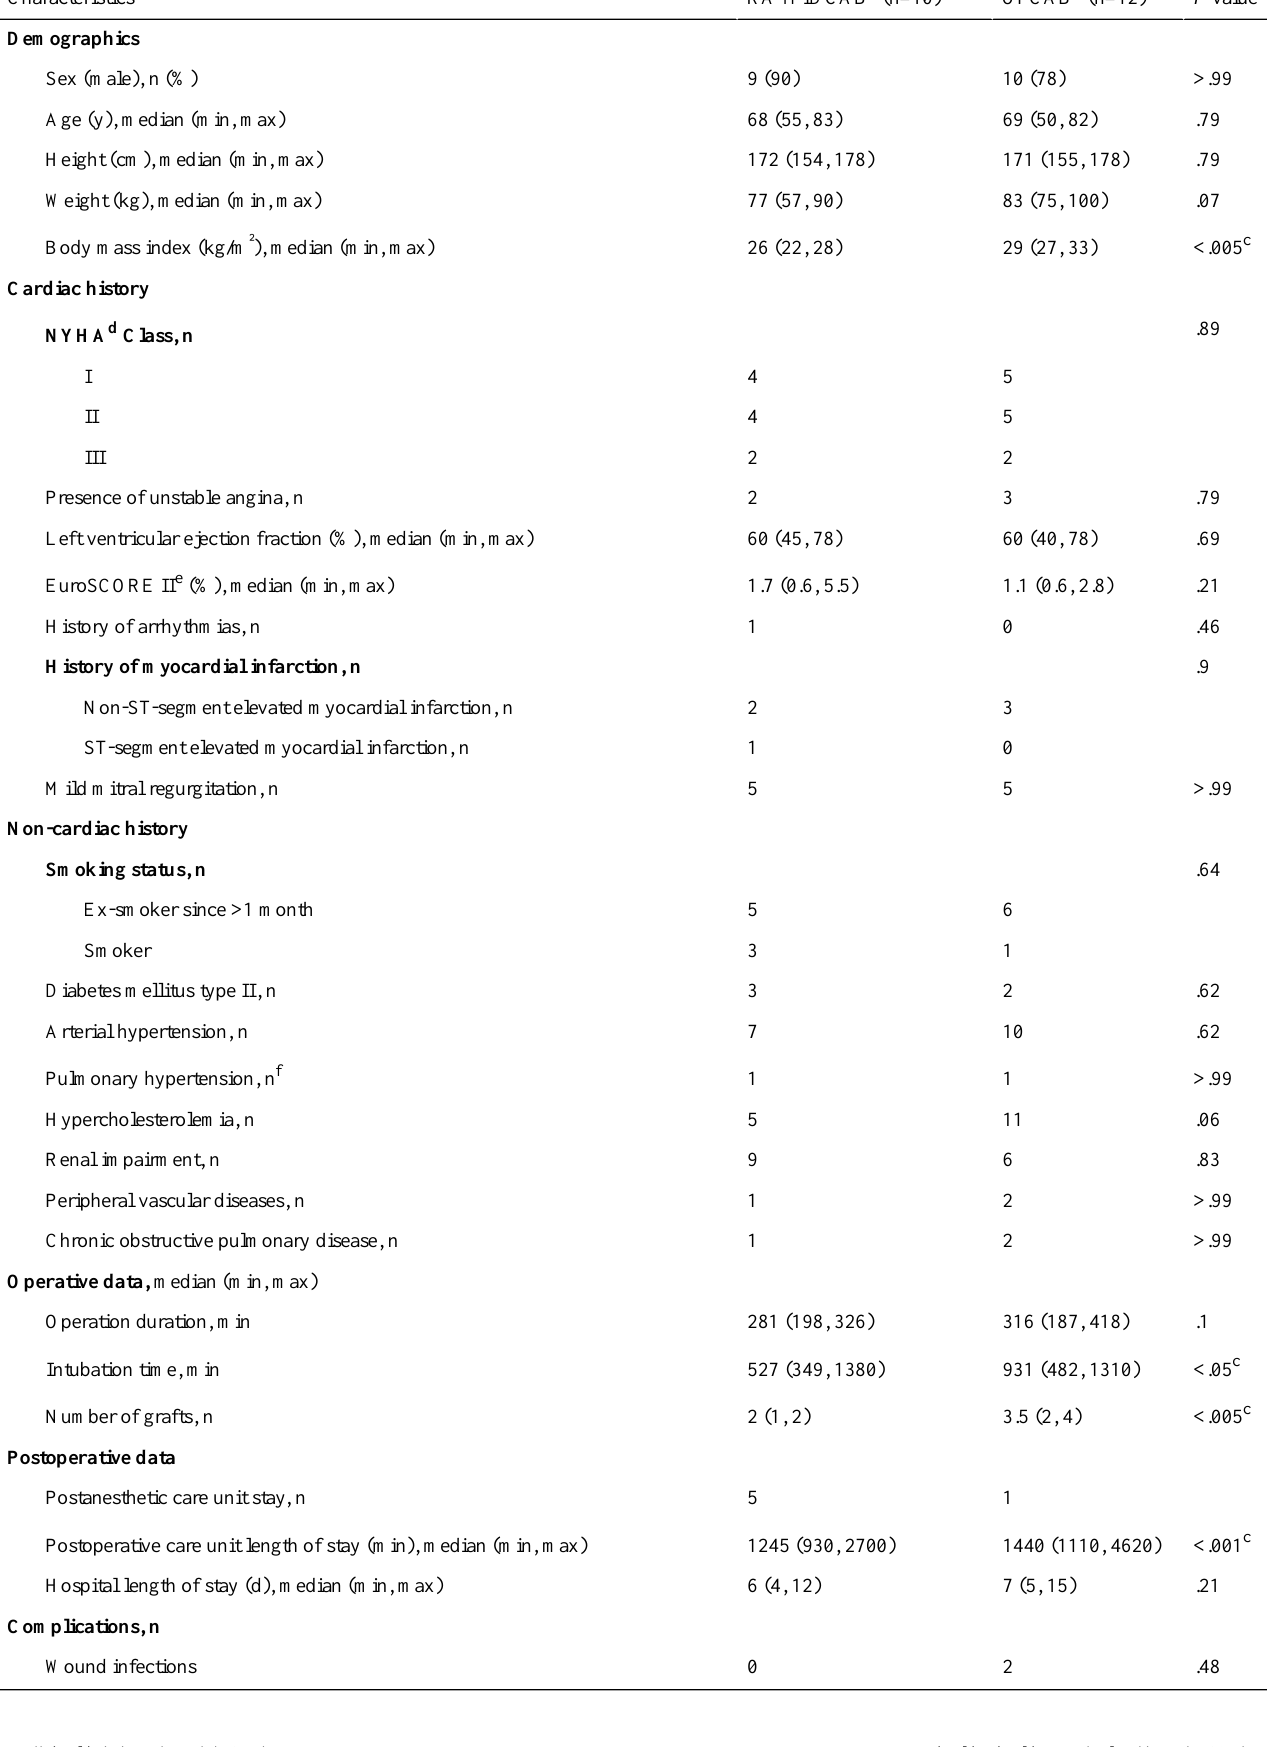
Table 1. Baseline characteristics and postoperative